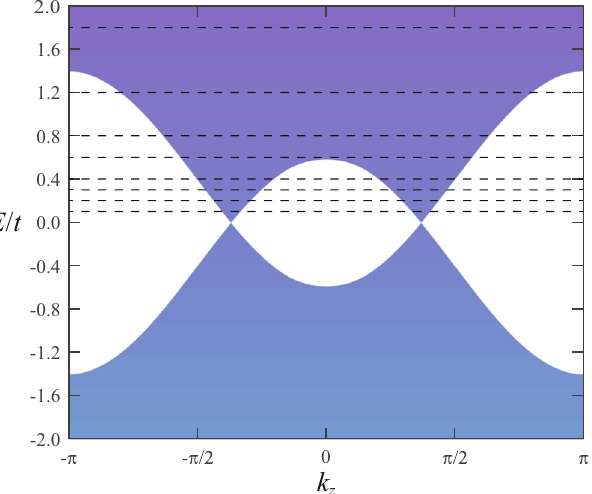
Figure 3. Bulk energy bands of the clean system (with the model parameters = . m m 2 19 − E t / plane. The dashed lines (from down to up) denotes the Fermi energies E t / projected onto the k z 0.2, 0.3, 0.4, 0.6, 0.8, 1.2, 1.8, respectively, that are used for localization length calculations, as shown in Fig.